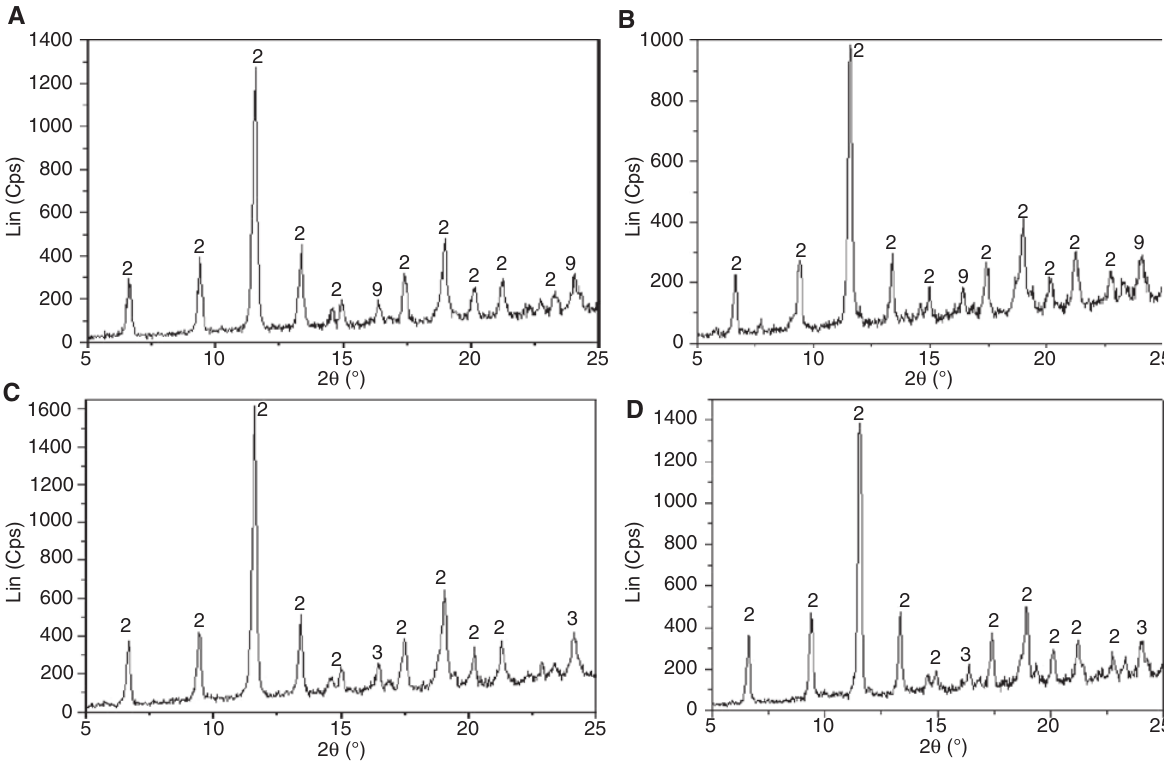
Figure 6: X-ray diffraction patterns of Cu-BTC, formed from Cu and benzene-1,3,5-tricarboxylic acid, synthesized in DD2 with different times: